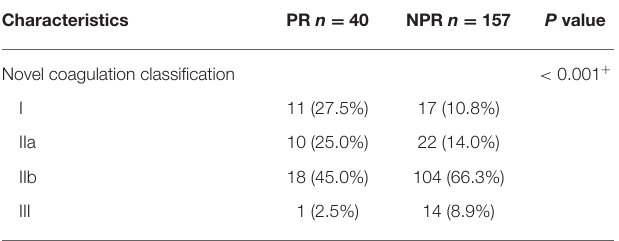
TABLE 1 | The information of included patients with